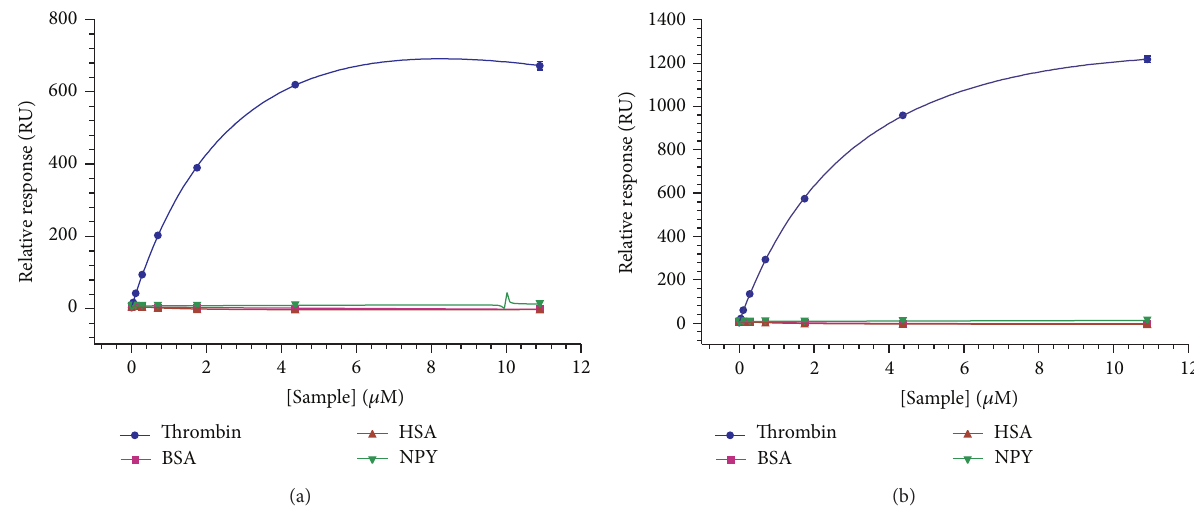
Figure 2: SPR response of 4A018 with analytes in flow channel 3 (a) and flow channel 4 (b). Analytes assayed were thrombin (circle), BSA (square), HSA (triangle), and NPY (downward triangle) at 0–10.9 𝜇 M. Error bars represent standard deviation of replicates for the mean of three separate experiments each performed in triplicate.